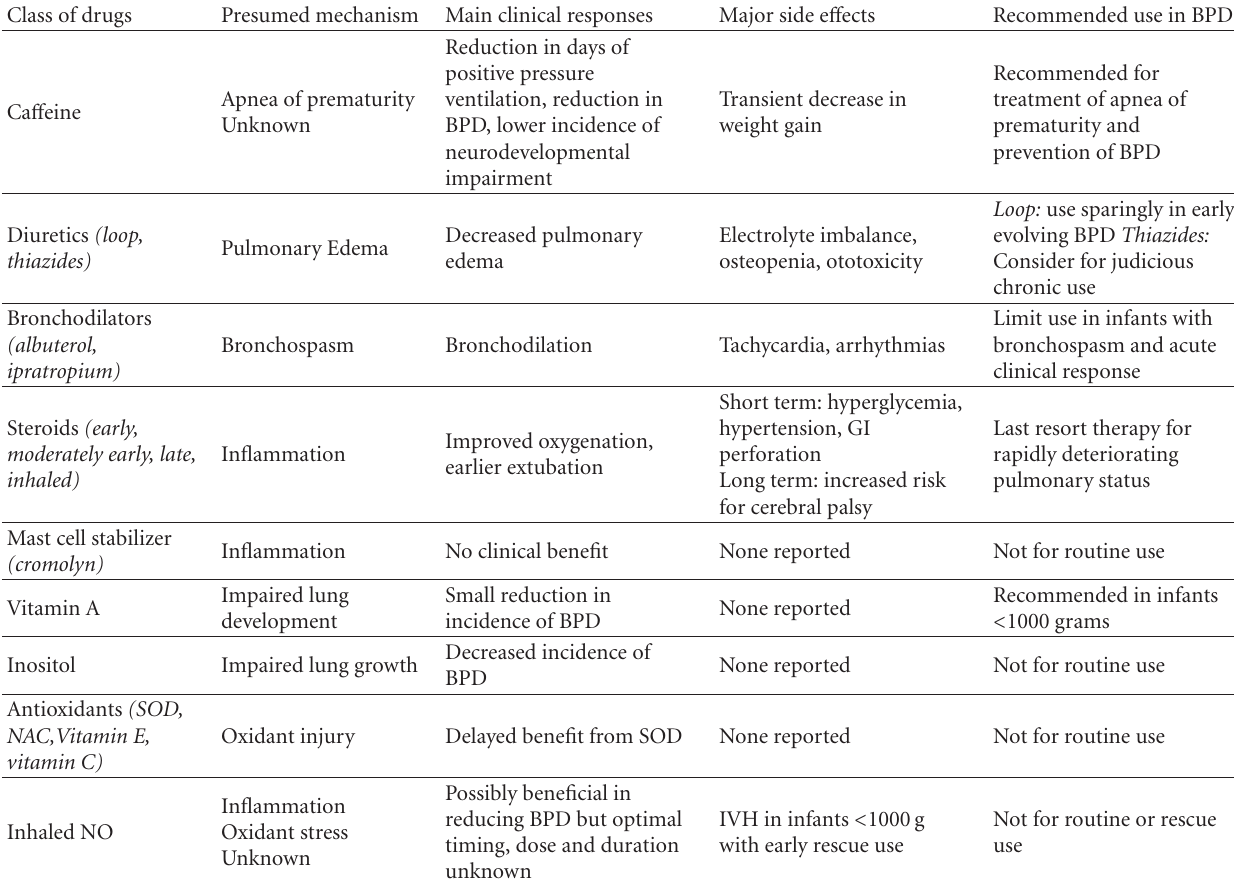
Table 1: Pharmacological interventions for prevention and management of